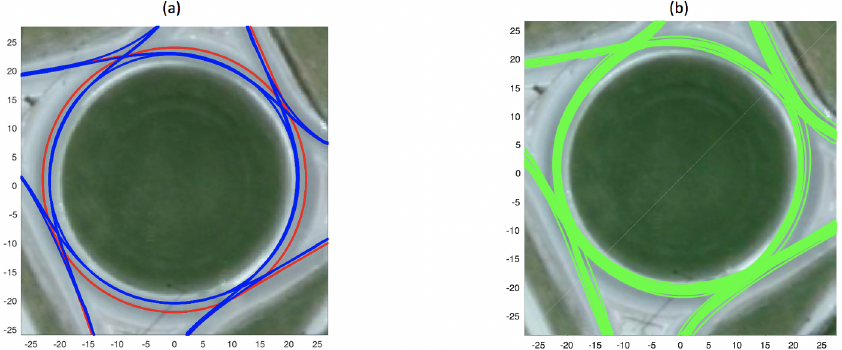
Figure 1. ( a ) Geometry (red) and mean of trajectories (blue) based models of the roundabout; and ( b ) model based on a set of reference trajectories. Each trajectory plotted in green represents a path taken by a real vehicle inside the roundabout (units in